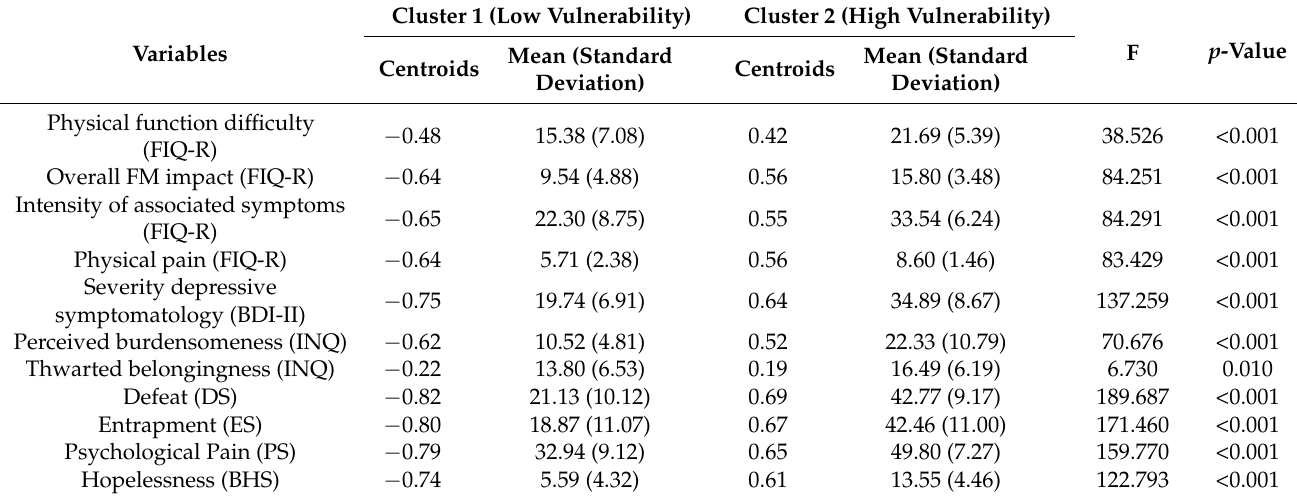
Table 2. Mean and standard deviation, centroids, and ANOVA for the solution of two